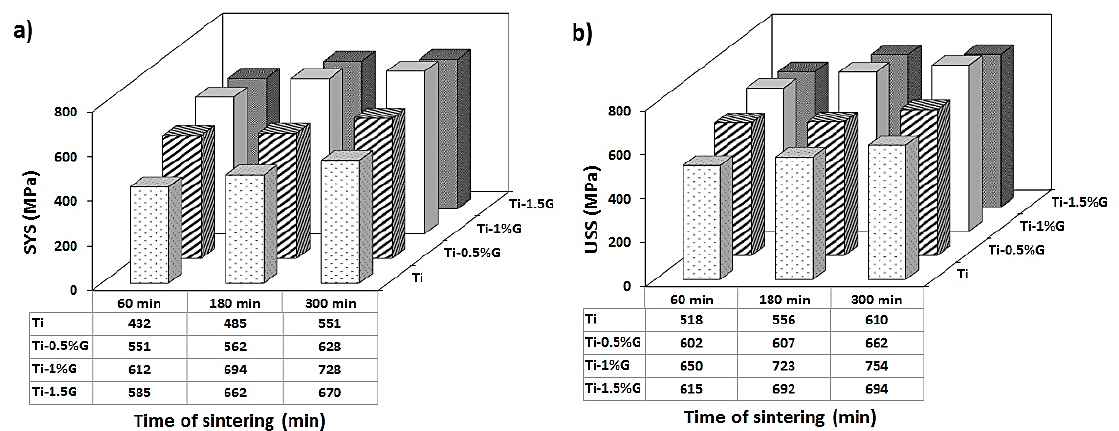
Figure 9. 3-D column diagram of the effect of GNSs’ weight percentage on shear yield stress (SYS) ( a ) and ultimate shear stress (USS) ( b ) of titanium matrix composite sintered at different time periods.